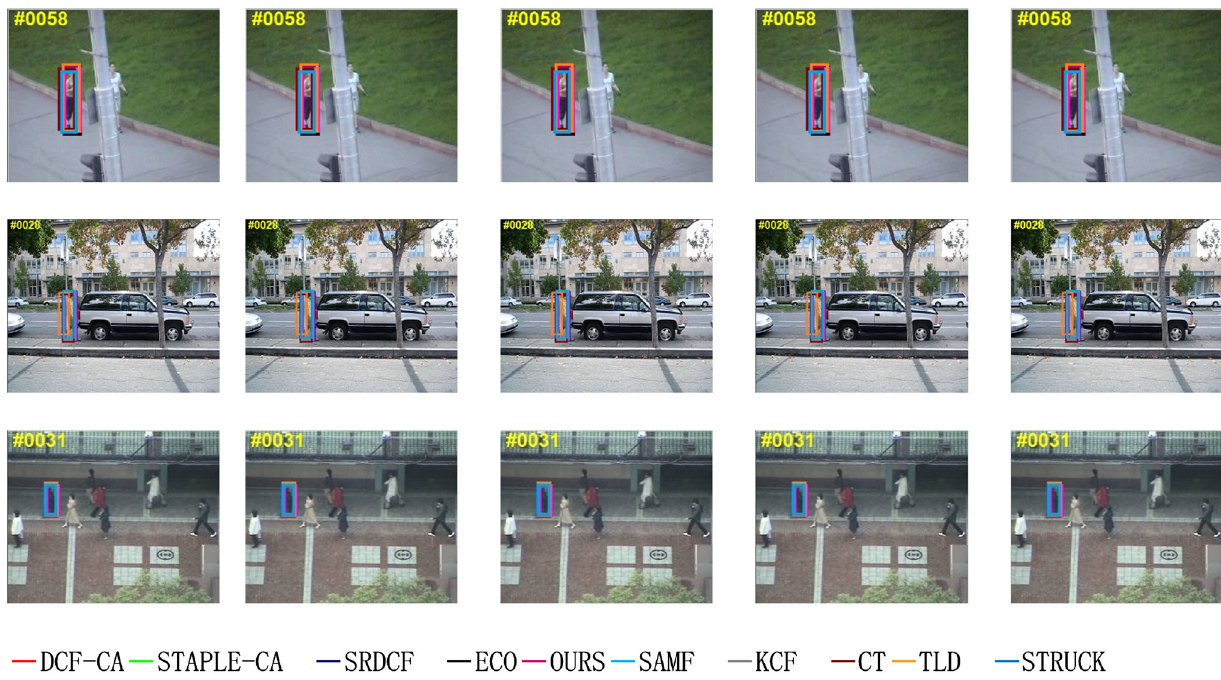
Fig. 10 Tracking effect of multiple trackers under fast-moving and cluttered background